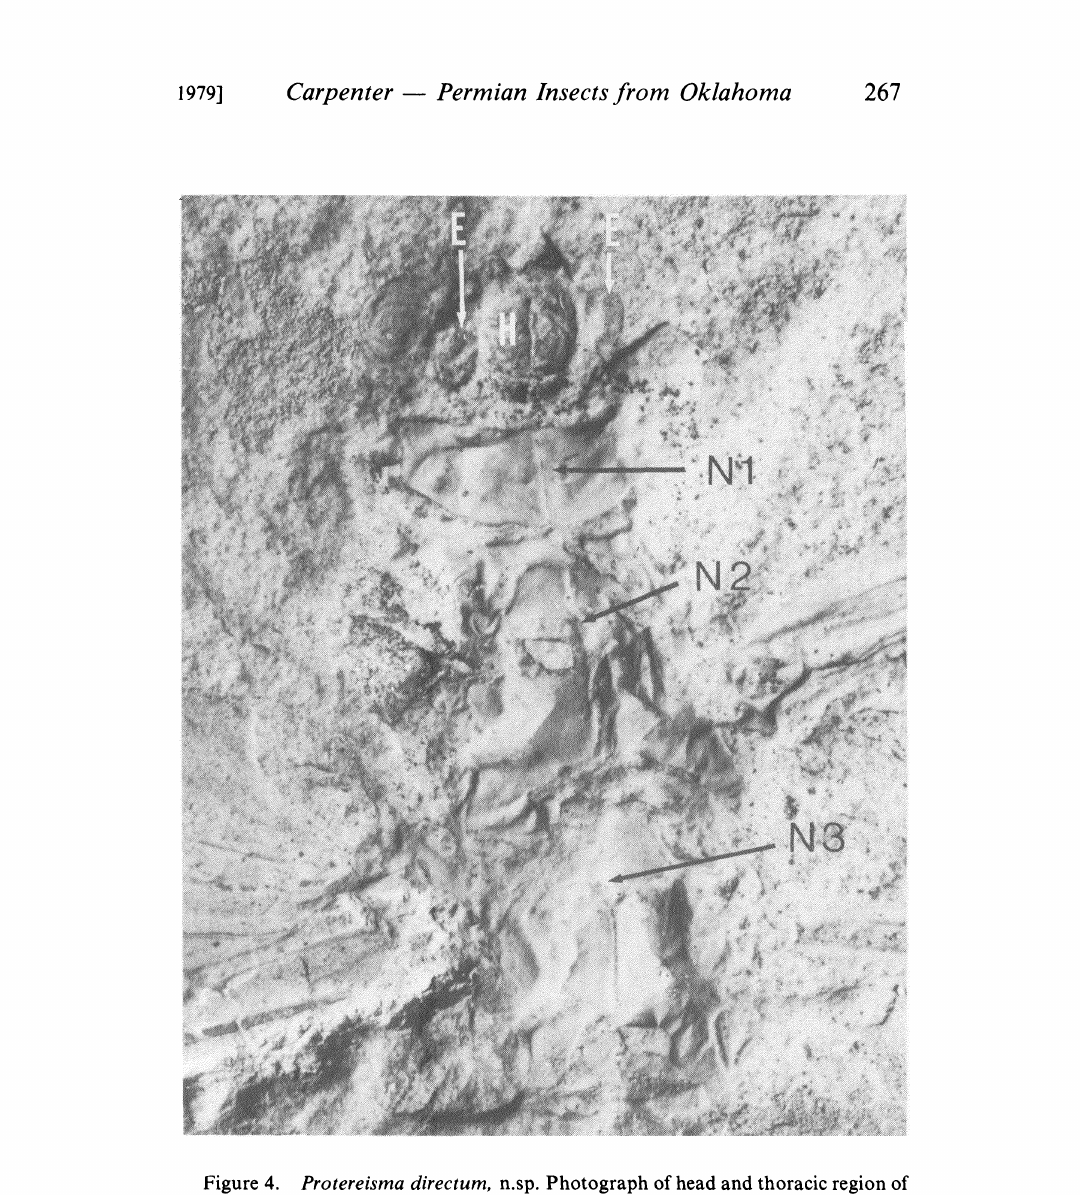
Figure 4. Protereisma directum, n.sp. Photograph of head and thoracic region of paratype, MCZ 5182a, showing eyes (E), head proper (H), pronotum (N1), mesono- tum (N2), and metanotum (N3). The left fore wing is preserved with its posterior margin directed anteriorly, as shown in figure 3. The dark circular object to the left of the head is a shell of a